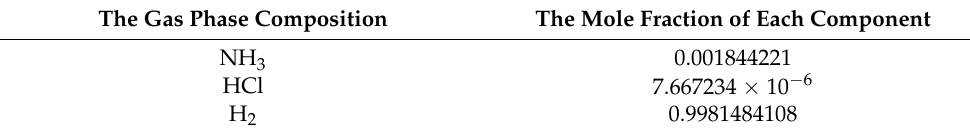
Table 3. Gas phase component content at